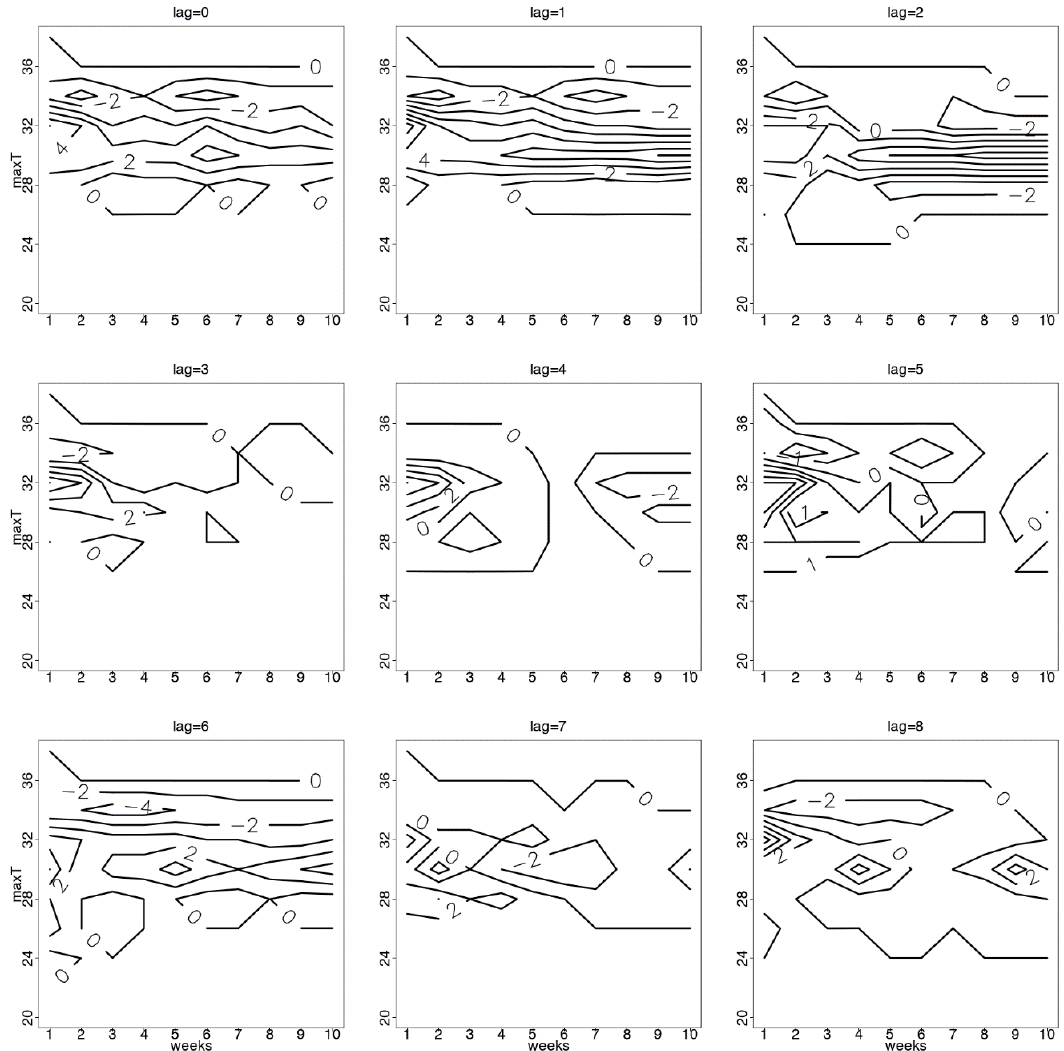
Figure 7. There were no statistically significant contour differences in anomalously high and low diarrhoea case counts for lag 0 to 8 weeks per consecutive weeks of maximum temperature among individuals 5 years of age and older for season DJF. X-axis represents number of consecutive weeks in which the average temperature reached over Y-axis representing temperature in degrees Celsius (°C). Warm colours represent higher frequency of (X, Y) occurring when diarrhoea case counts were anomalously higher than average.